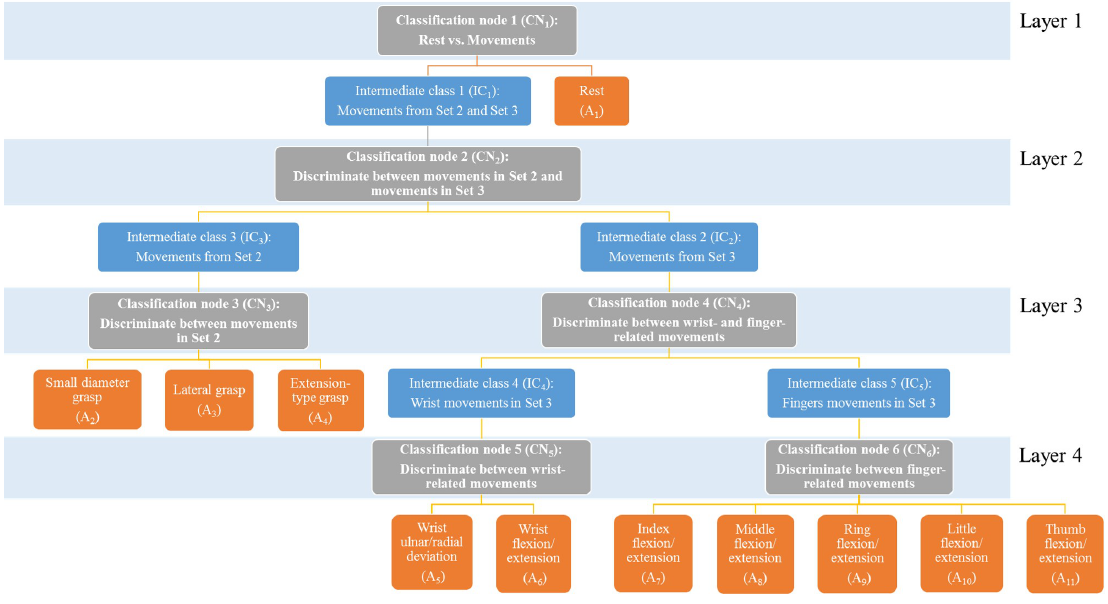
Figure 5. Illustration of the structure of the proposed four-layer hierarchical classification model. Nodes in gray color represent the classification nodes in each layer. Orange nodes represent the eleven classes of the HMITs in our study. Blue nodes represent an intermediate classes of EEG